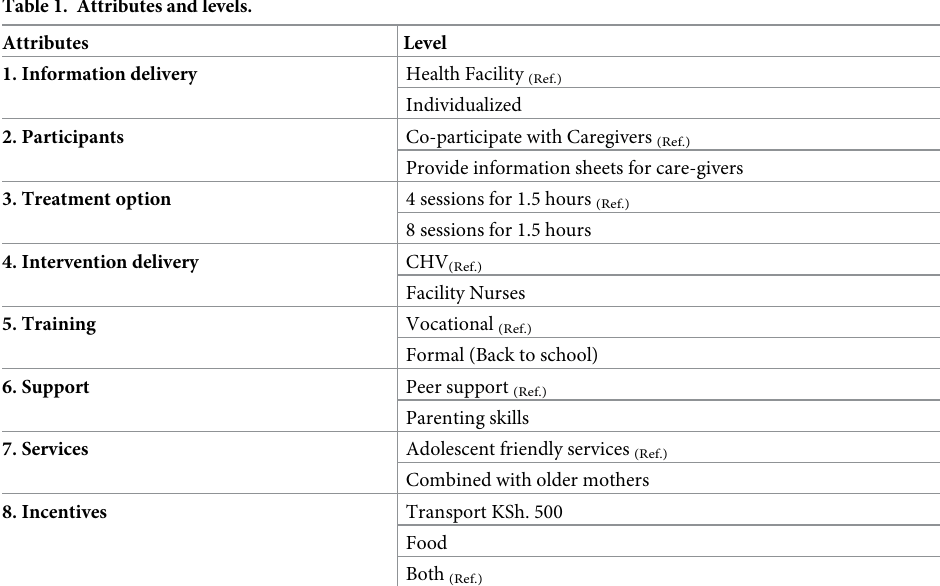
Table 1. Attributes and